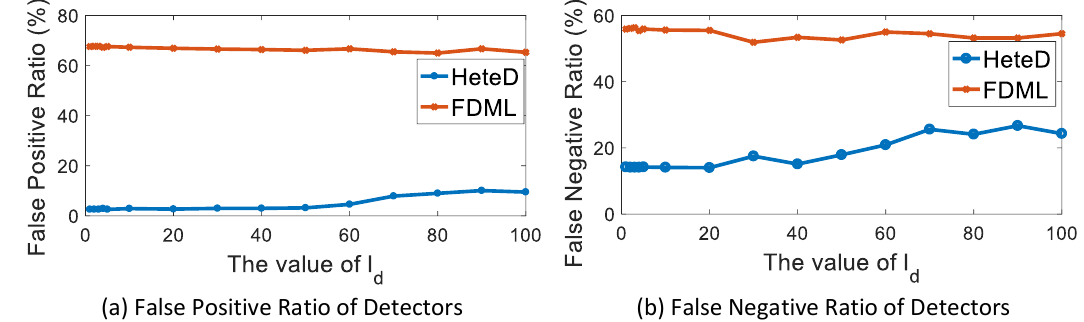
Figure 7. Detection performance of detectors on the smart